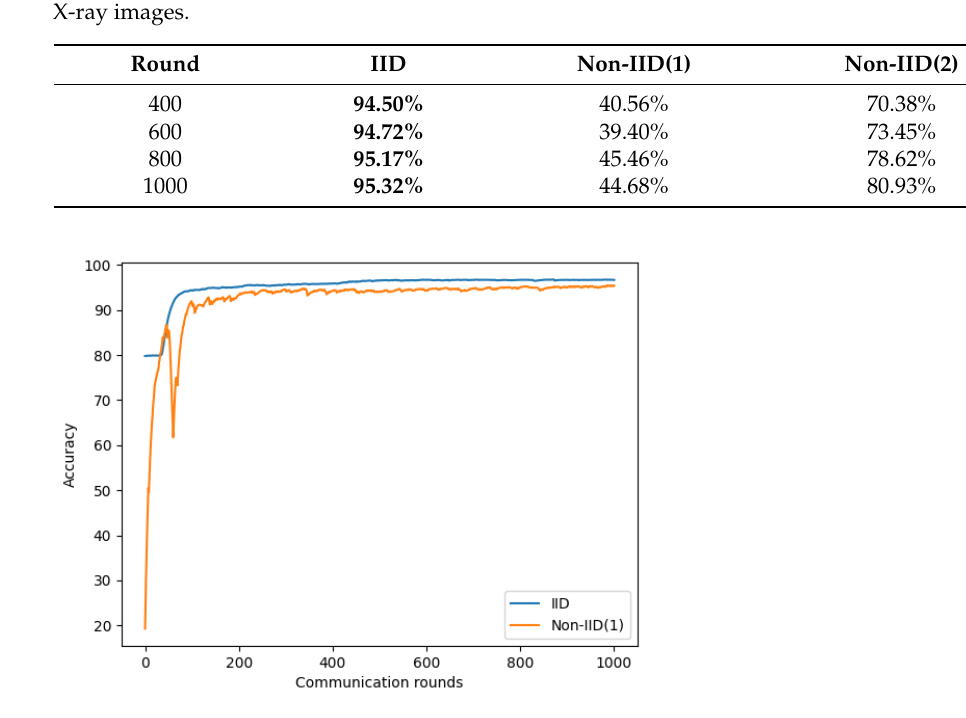
Figure 11. Performance comparison between IID and Non-IID based on symptom dataset. Table 7. The summary table of the performance comparison between IID and Non-IID based on symptom